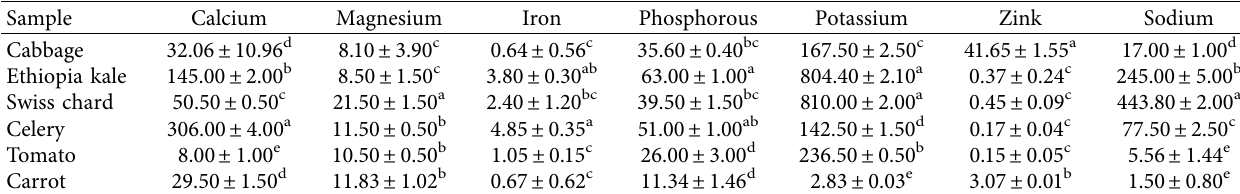
Table 2: Mineral contents (mg/100 g, dwb) of composite vegetable